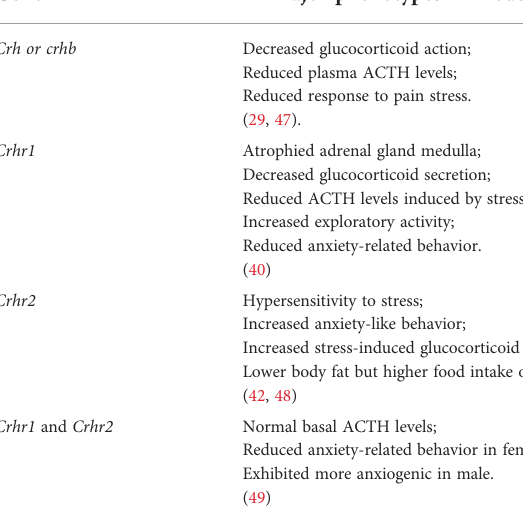
TABLE 1 Phenotypes of CRH-related gene knockout or knockdown mouse and fi sh models. Gene Major phenotypes in mouse